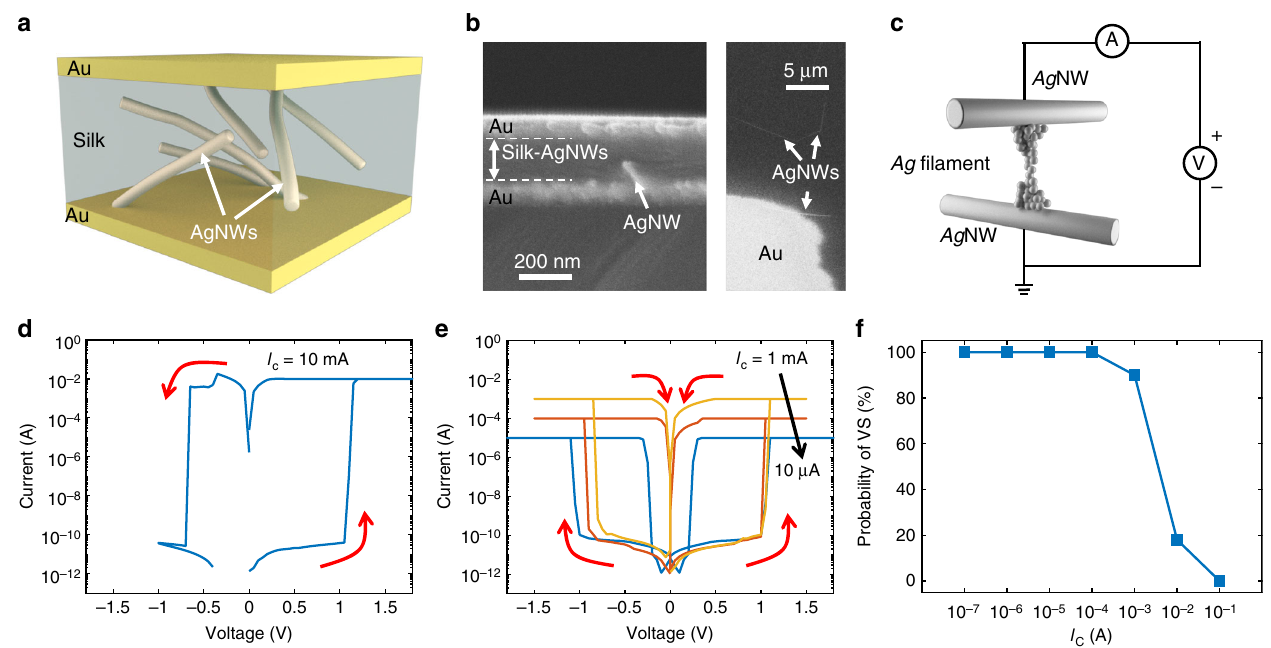
Fig. 1 Volatile and non-volatile switching of RS devices. a Schematic structure of a RS device based on Ag NWs. Bottom and top Au layers act as contact pads, Ag NWs act as effective bottom and top electrodes for the CF formation, and silk acts as insulating switching layer. b Sectional (left) and top planar (right) SEM views of the RS device. c Illustration of the metallic CF formation between two Ag NWs. A metallic CF can be formed in response to the application of a large voltage to the electrodes. In non-volatile switching, the CF can remain in the connected state for a relatively long time until another voltage pulse induces its disconnection. On the other hand, in the case of volatile switching, the CF retracts back to the electrodes immediately after set transition. d I – V characteristics for non-volatile switching for a high compliance current I C = 10 mA. When a positive sweep voltage is applied, the current increases sharply, indicating the formation of the metallic CF. The compliance current I C across the device controls the size of the formed CF. After the positive voltage sweeps back to zero, the device still remains in the low resistance state. As a negative voltage is applied, the device switches to the high resistance state indicating CF disruption. e I – V characteristics for volatile switching of the device at low I C . When a positive sweep voltage is applied, the current increases sharply indicating CF formation. However, the device quickly switches back to its original high resistance state after the forcing voltage is swept to zero. Bidirectional volatile switching is observed, as the application of a negative voltage also generates a metastable CF. f Probability for volatile switching (VS) as a function of I C , indicating the transition from volatile switching to non-volatile switching at increasing I